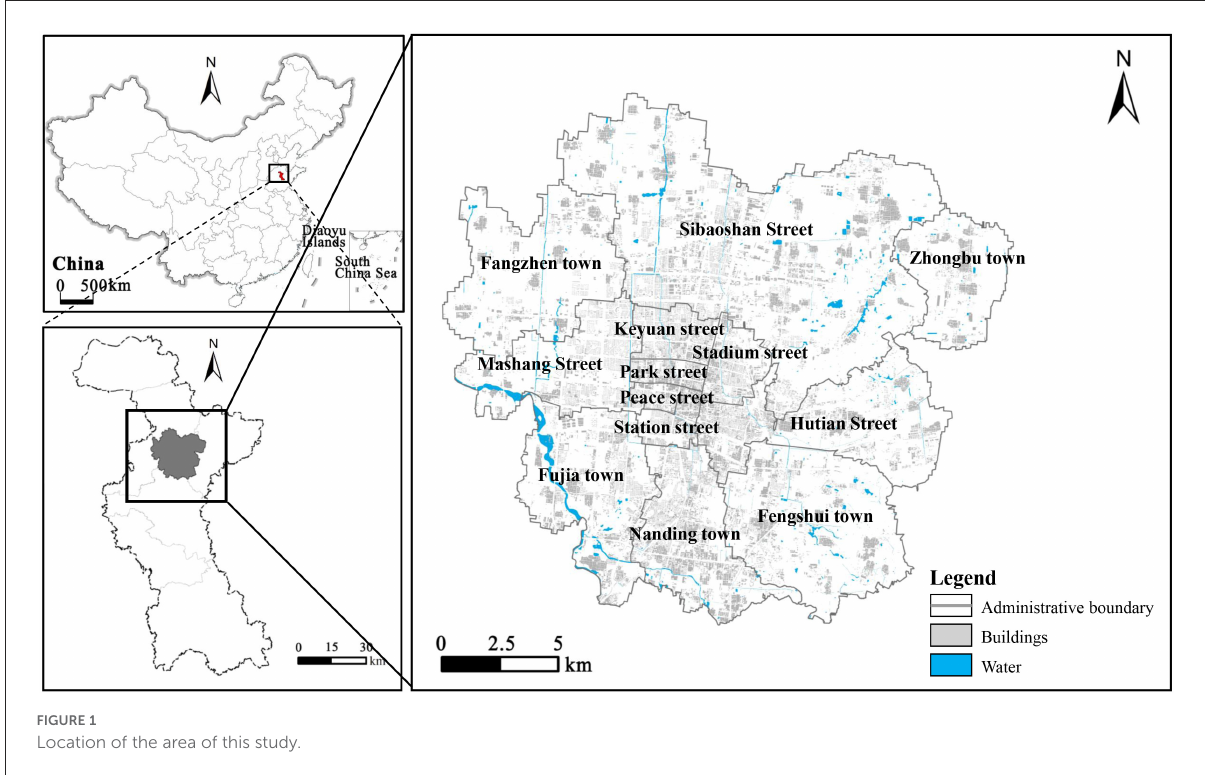
FIGURE1 Location of the area of this study.